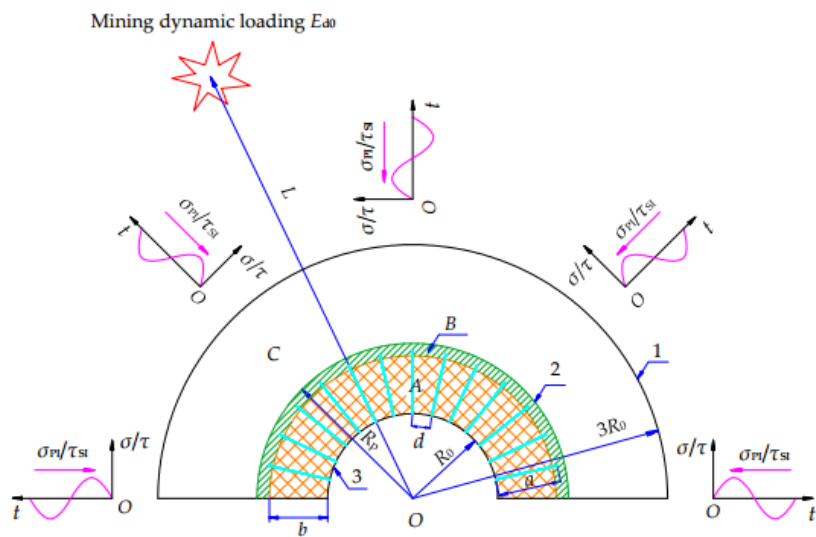
Figure 1. Mechanical model for the supporting structure of roadways under mining-induced dynamic loads.